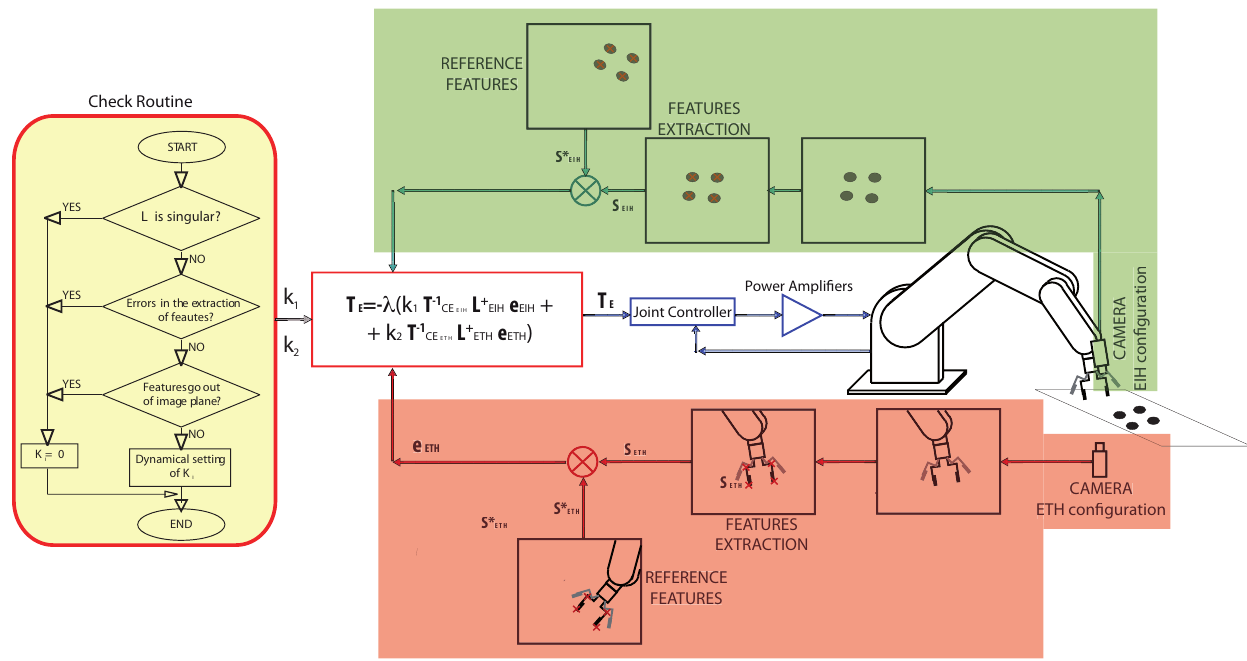
Figure 2. General architecture of the proposed controller.